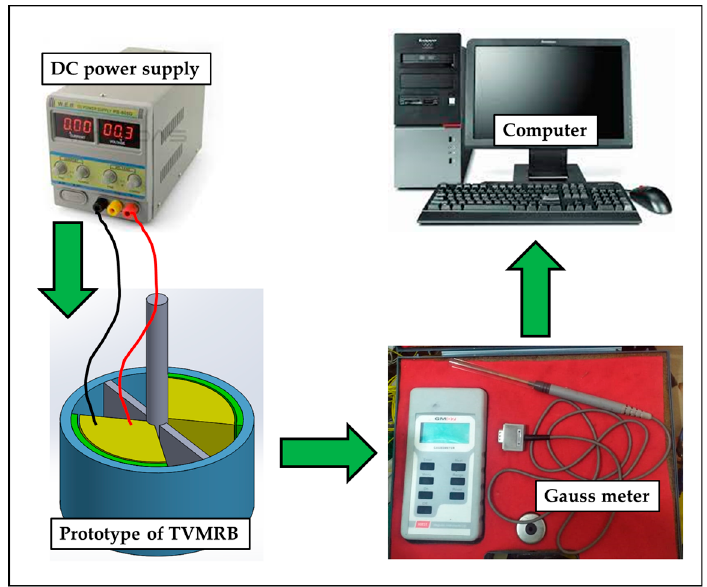
Figure 10. Schematic of magnetic flux density testing on the TVMRB prototype.